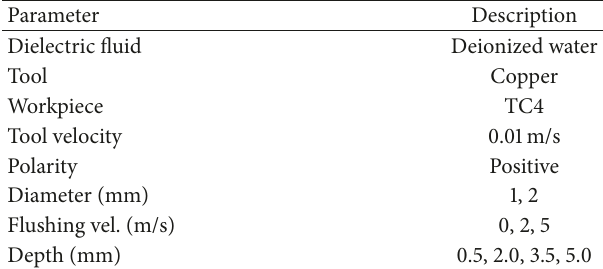
Table 1: Continuous discharge simulating